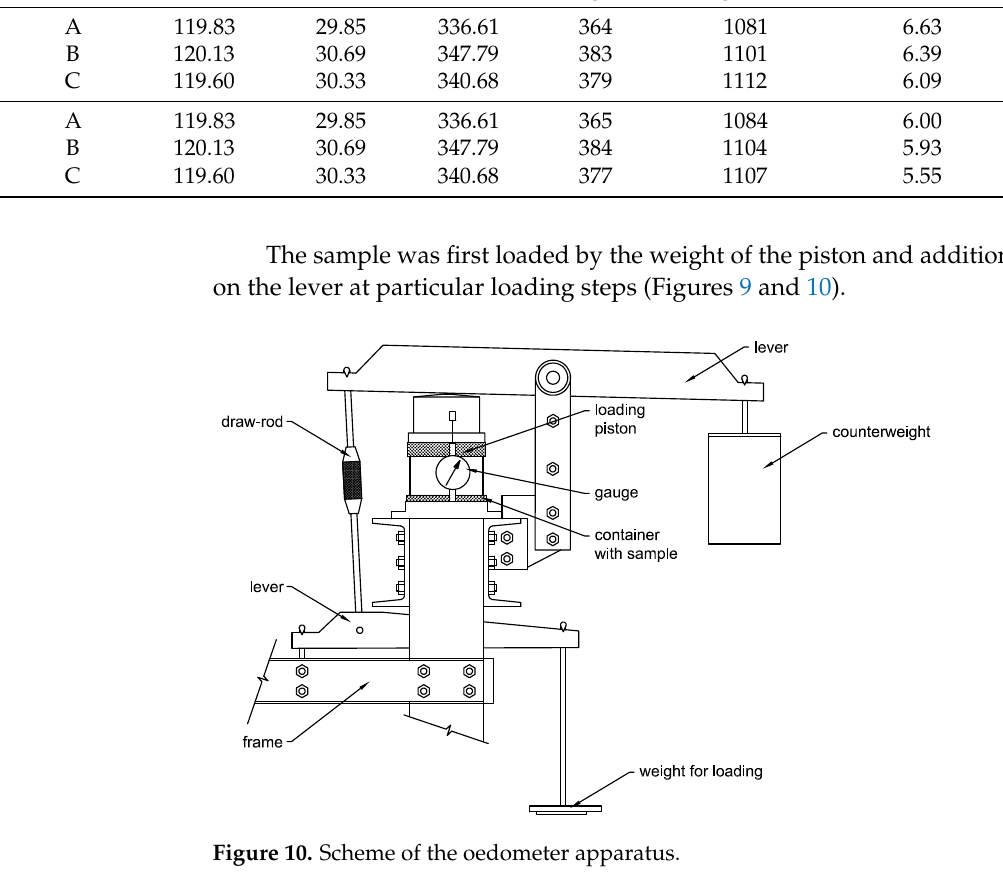
Figure 9. Sample of kinetic sand in the container of oedometer apparatus. ( a ) Original sample before testing; ( b ) Boiled sample after testing.